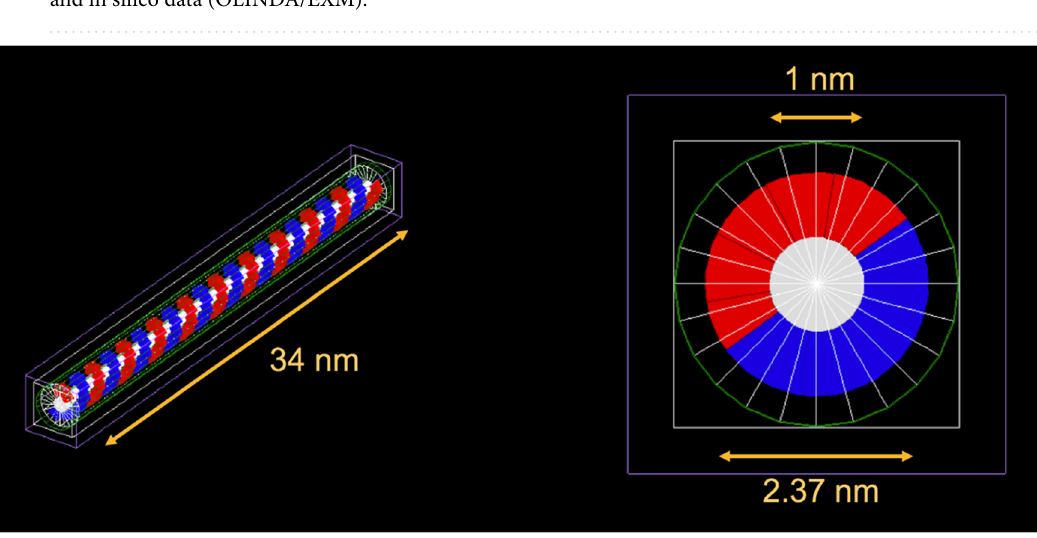
Figure 4. Linear DNA model in TOPAS-nBio, consisting of the sugar phosphate backbone (blue and red), bases (white) and volumetric source (green). 100 bases are simulated, with a total DNA length of 34 nm, outer and base diameter of 2.37 and 1 nm,